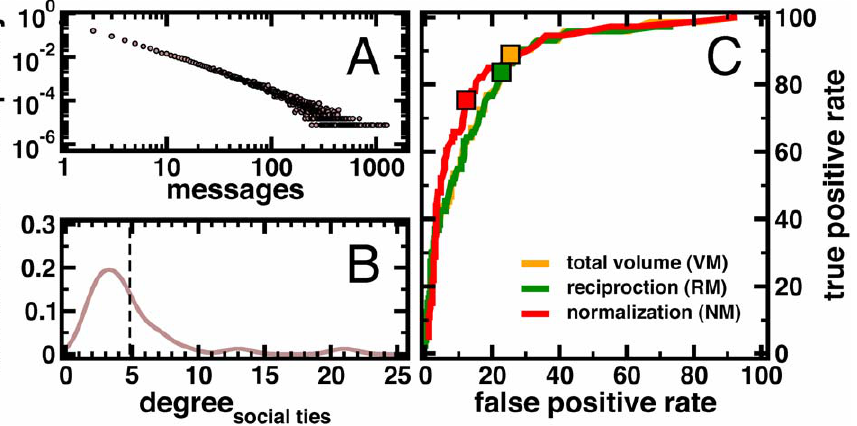
Figure 1. Data characteristics and ROC curves of conversion methods. ( A ) Counting the number of email messages that flow between a pair of persons we observed a strong power-law. ( B ) In the distribution of social ties a person is involved in, we found 4.8 6 3.8 contacts per person (dashed line). ( C ) Utilizing our methods, we converted emails to social attachments. ROCs indicate good agreement levels , comparing predicted ties to self-reported contacts (Area Under the ROC Curve (AUC) criterion: Normalization Method AUC=0.891, Reciprocation Method AUC=0.867, and Total Volume Method AUC=0.867). Utilizing total volume method (VM), we indicated best TPR=76.7% and FPR=18.2% values that corresponded to the maximum correlation threshold between self-reported and predicted ties by a square. Analogously, we found TPR=83.6% and FPR=22.7 utilizing the reciprocation method (RM) and TPR=75.3% and FPR=12.2% using the normalization method (NM).